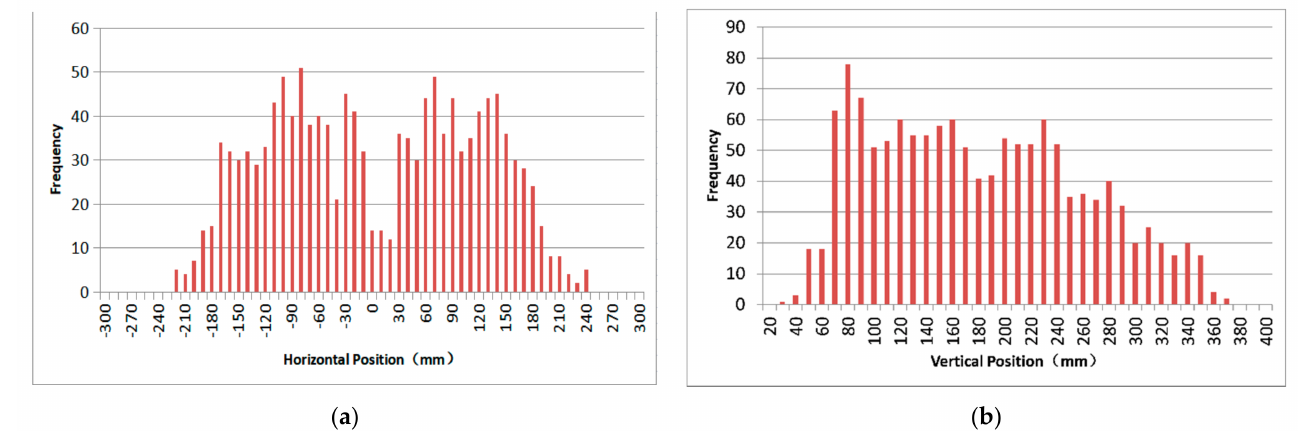
Figure 3. The results of the pilot study: ( a ) the results of the horizontal experiment; ( b ) the results of the vertical experiment.